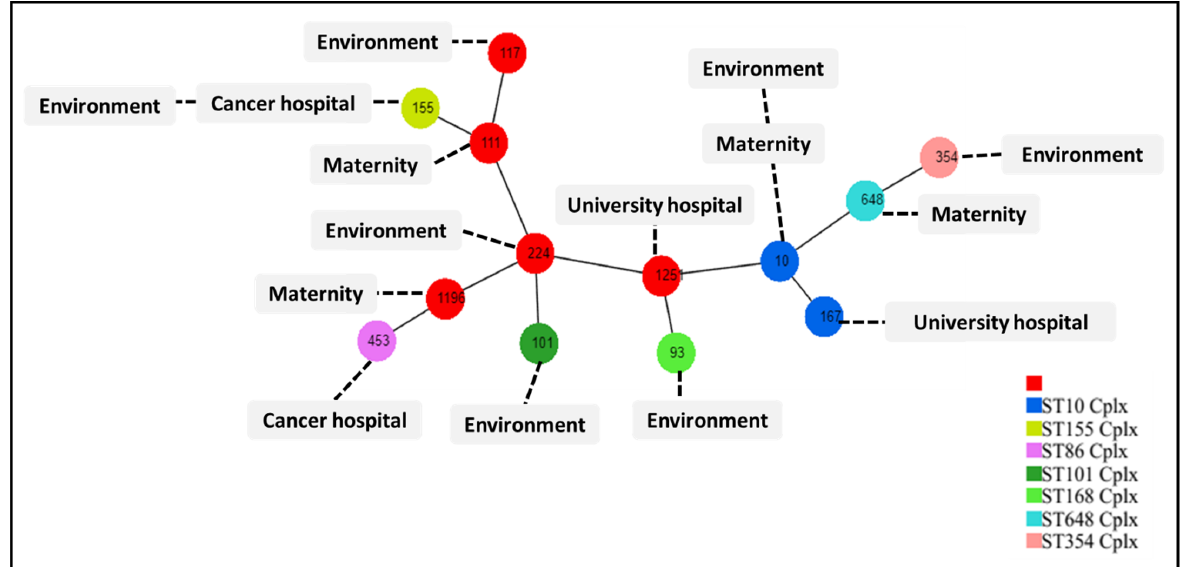
Figure 5. MLST dataset generated using PHYLOViZ Online, indicating STs of our mcr-1 positive E. coli isolates. The numbers in the circles indicate the Sequence Types (ST).